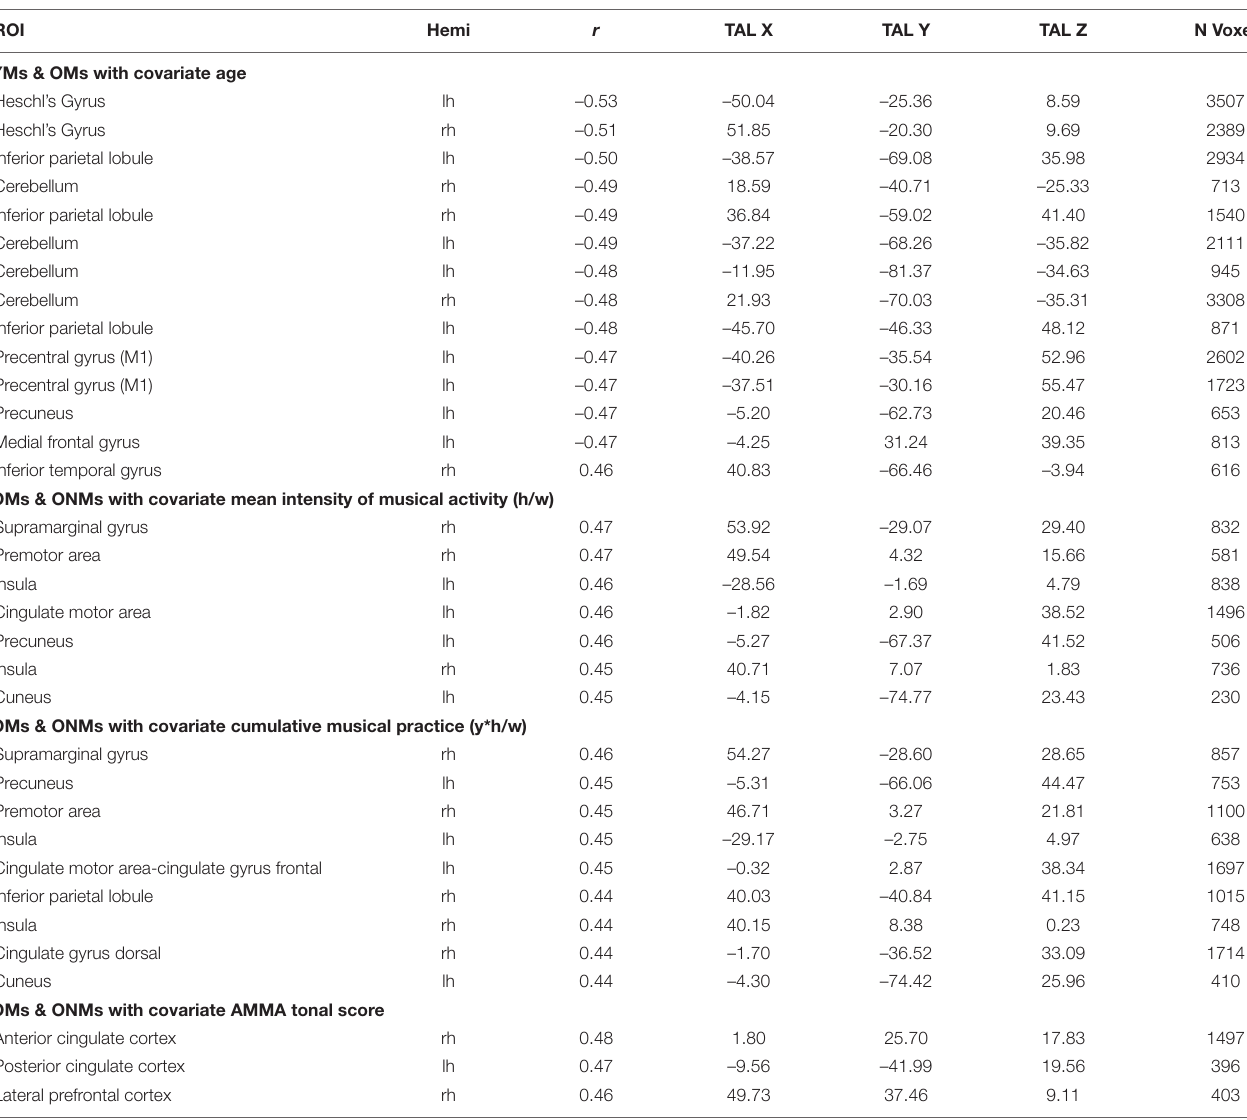
TABLE 3 | Random effects (RFX) functional